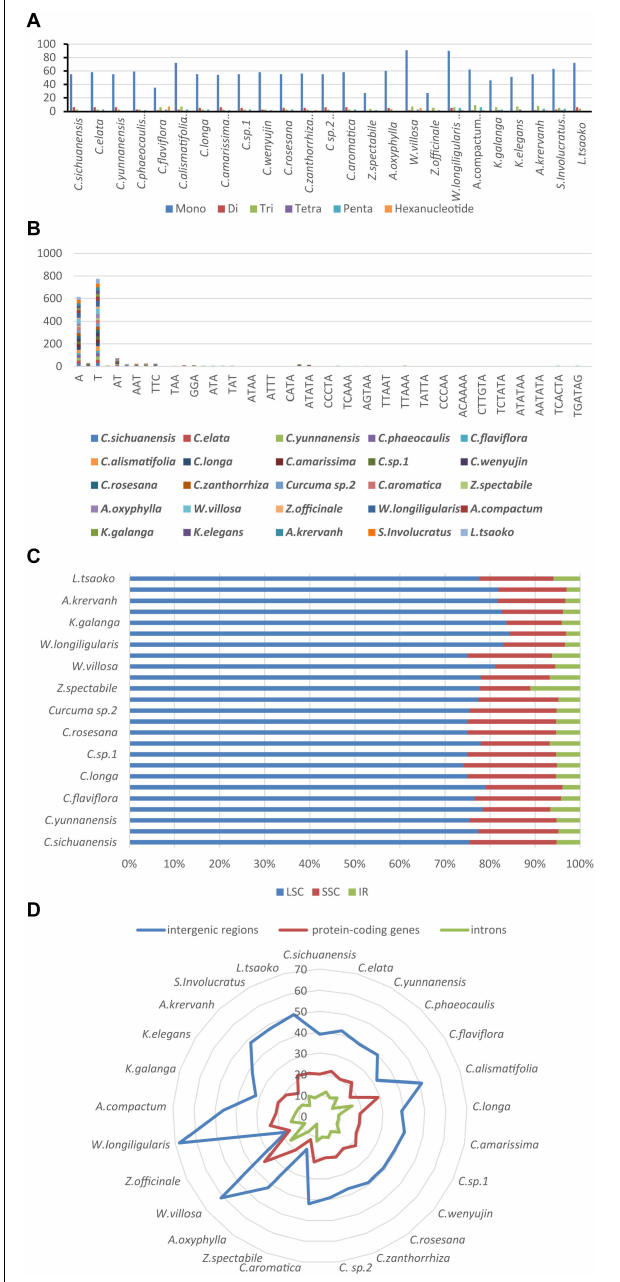
FIGURE 5 | The comparison of SSR distribution in 25 chloroplast genomes; (A) number of different SSR types; (B) frequency of common motifs; (C) frequency of SSRs in the LSC, IR, SSC region; (D) frequency of SSRs in the intergenic regions, protein-coding genes and